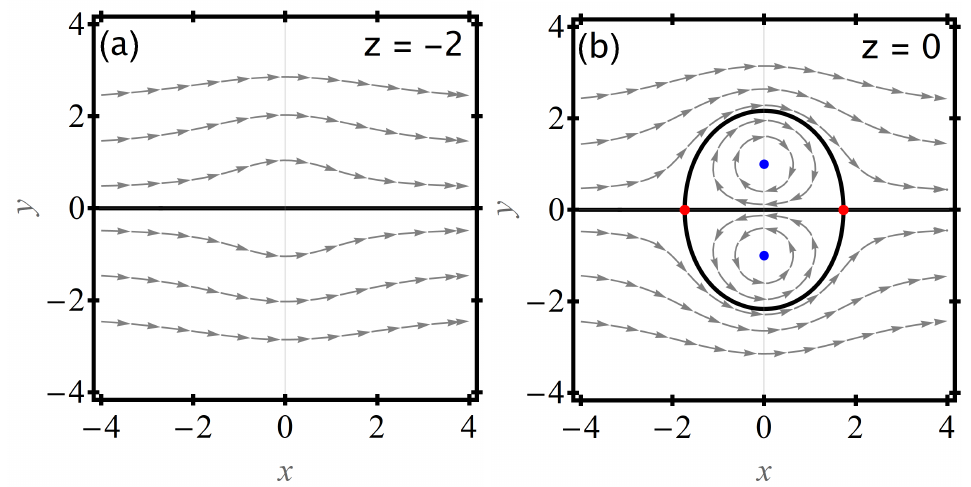
Figure 2. Phase portraits of the flow induced by a heton with Z = 0 on horizontal planes with ( a ) z = − 2, and ( b ) z = 0. These plots show the normalized planar velocity field (grey arrows), the heteroclinic separatrix ψ = 0 (black) that bounds the trapping region, and stable and unstable fixed points (blue and red dots, respectively). In panel ( a ), at ‘large’ distances from the heton, no fluid is trapped. Closer to the heton, as in panel ( b ), a trapping region